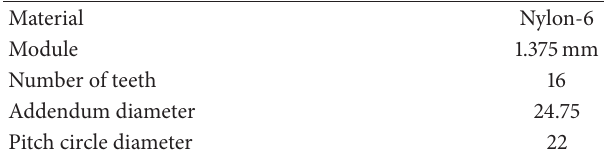
Table 11: Sun gear specification.